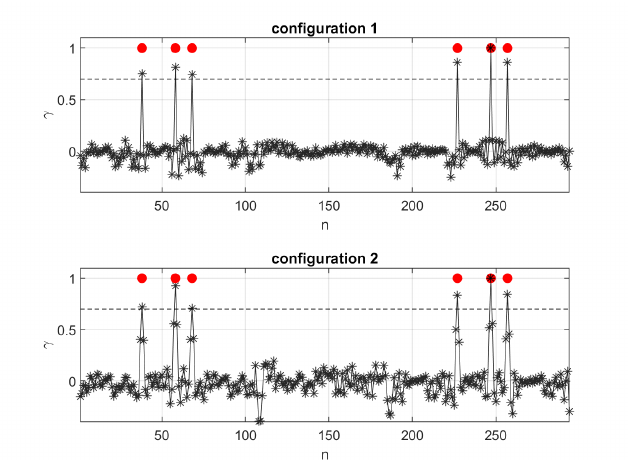
Figure 6. Bars’ detection ( top ) and reconstructed γ ( n ) for the two measurement configurations ( bottom ). Red circles represent actual bars (two bars lacking with respect to Figure 5). Black stars represent detected bars. A threshold of 0.7 has been applied.